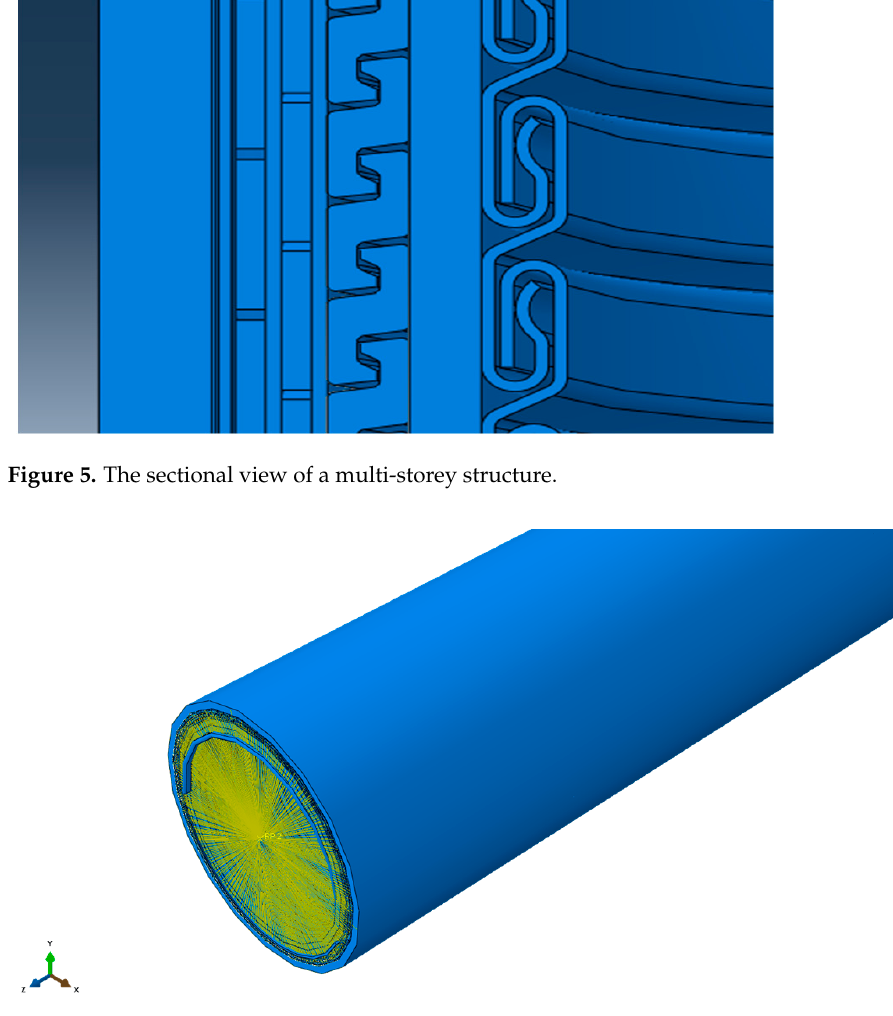
Figure 6. The boundary conditions of a multi-story structure.